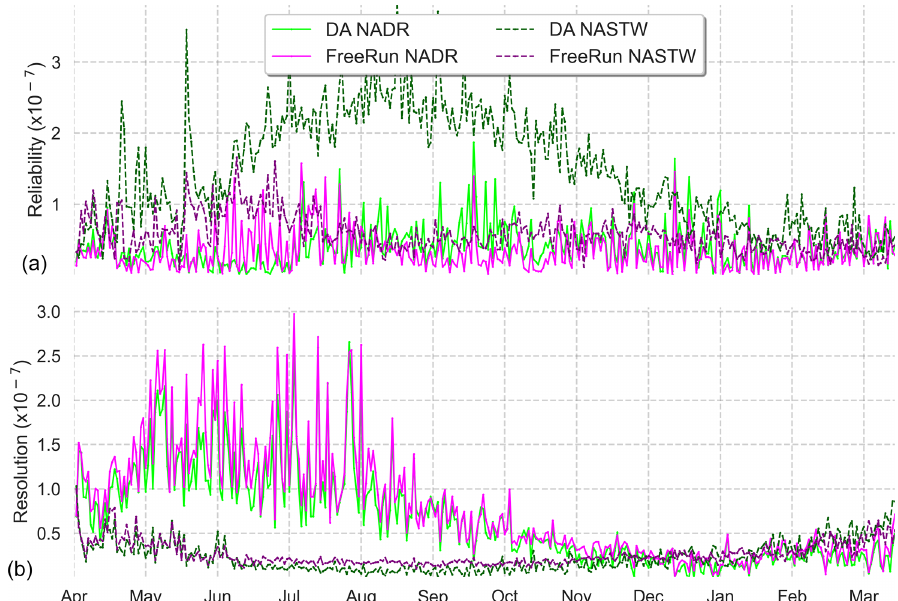
Figure 5. Time series (6 April 2005 to 5 April 2006) of reliability (a) and resolution (b) computed from CRPS decomposition for the 24- member free run (in magenta) and the 24-member forecast ensemble assimilation (in light green) experiments. Longhurst provinces NADR and NASTW are